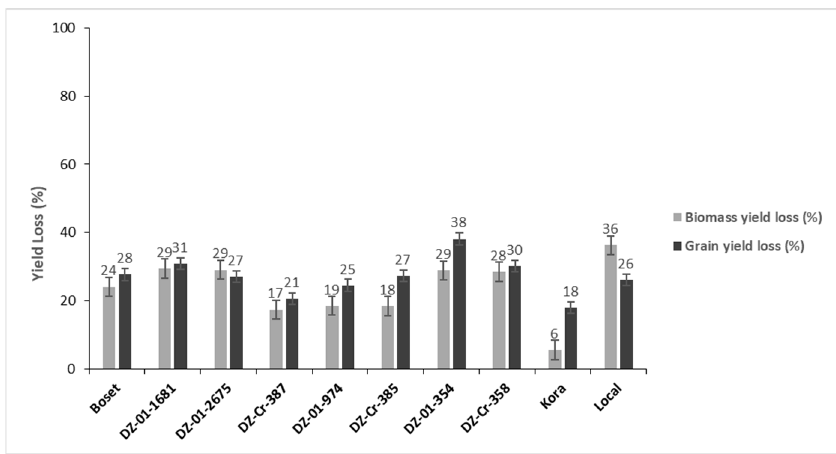
Figure 4. Biomass and grain yield losses of teff varieties due to weed competition in unweeded plots. N.B. Yield loss (%) = % of the yields obtained from weeded plots and lost due to the weed competition in unweeded plots